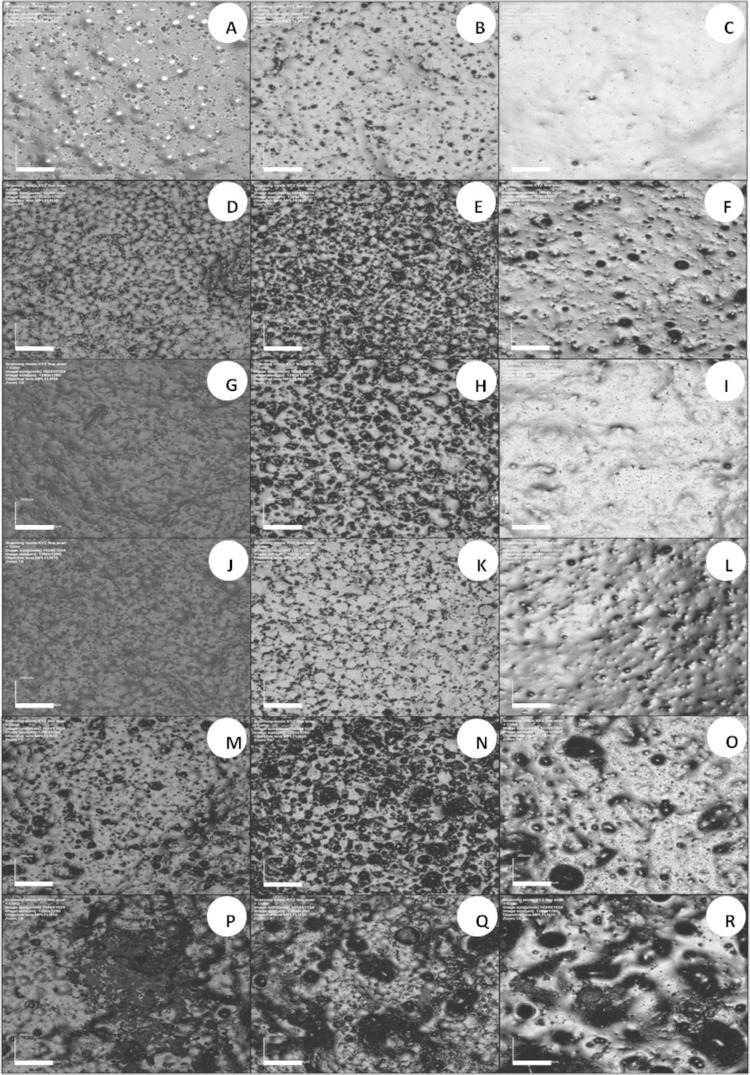
CLSM images of tissue conditioner Softone at 24-h (1st column), 7-day (2nd column), and 14-day intervals (3rd column). A to C – control; D to F – Ny; G to I – Mc; J to L – Ke; M to O – Chx; and P to R – It. Scale bar = 200 µm (Magnification 10x)